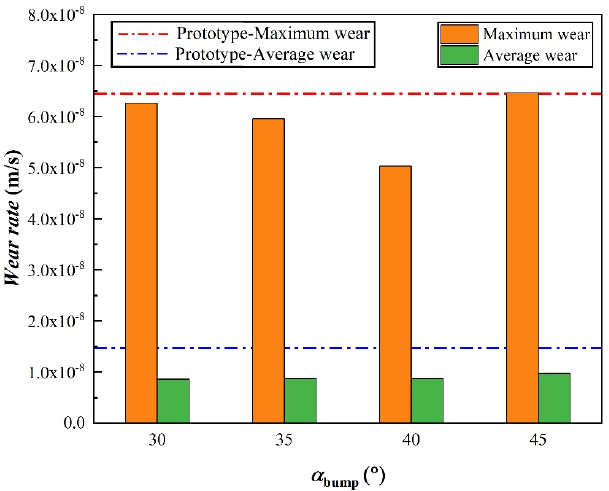
Figure 9. Schematic diagram of the relationship between the bump position and the wear rate.